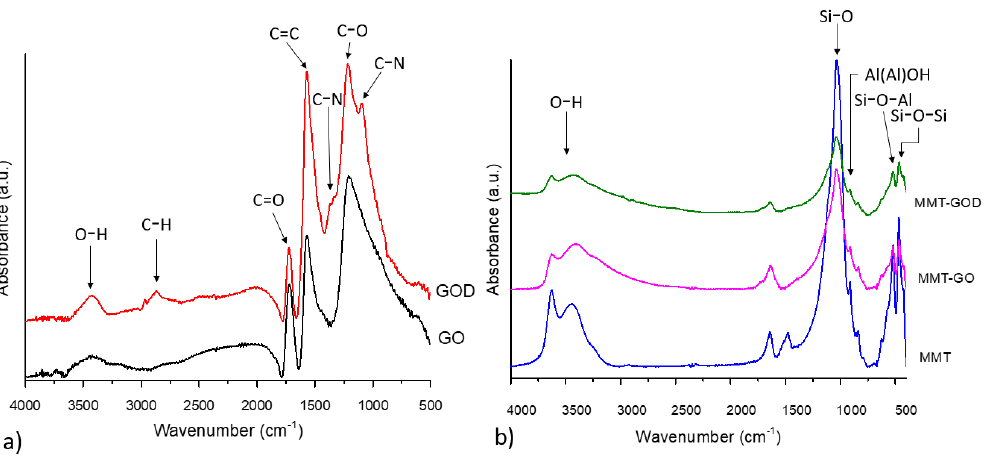
Figure 1. FTIR spectrum for: a ) GO nanomaterials and b ) MMT – GO based nanohybrid structures.